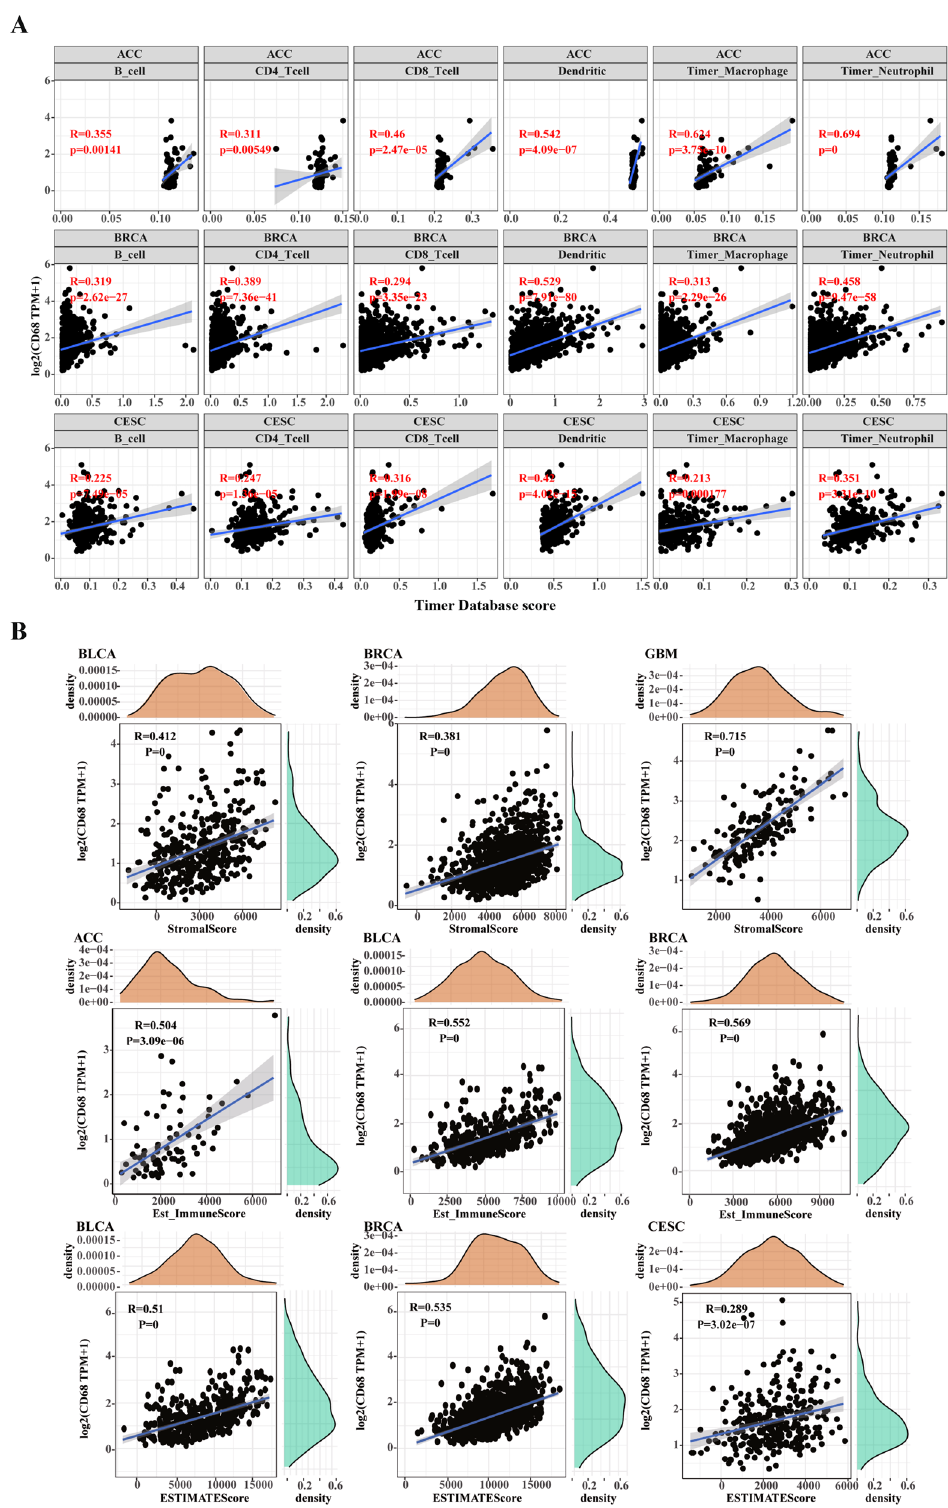
Figure 5. Correlation of CD68 expression with immune infiltrates based on the CIBERSORT analysis in pan- cancer. Top three cancer types that most related to immune cell infiltration ( A ) and stromal score, immune score, and estimate score ( B ) in